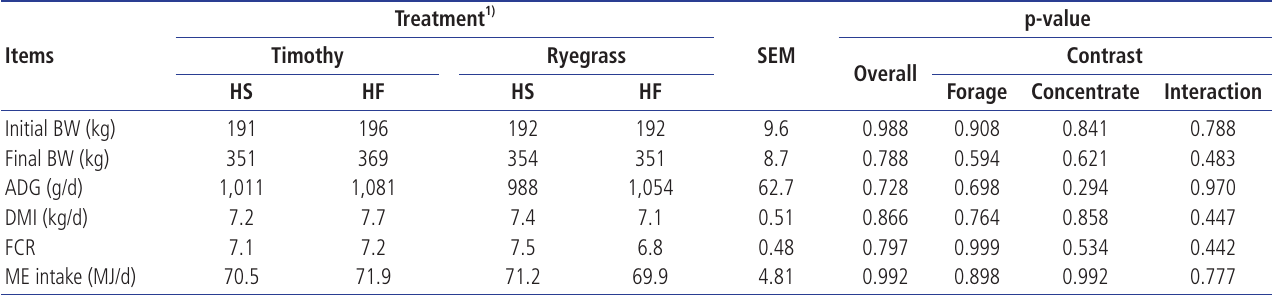
Table 3. Effect of the quality of forage and concentrate mix on growth performance and metabolic energy intake in Hanwoo calves (n = 24)